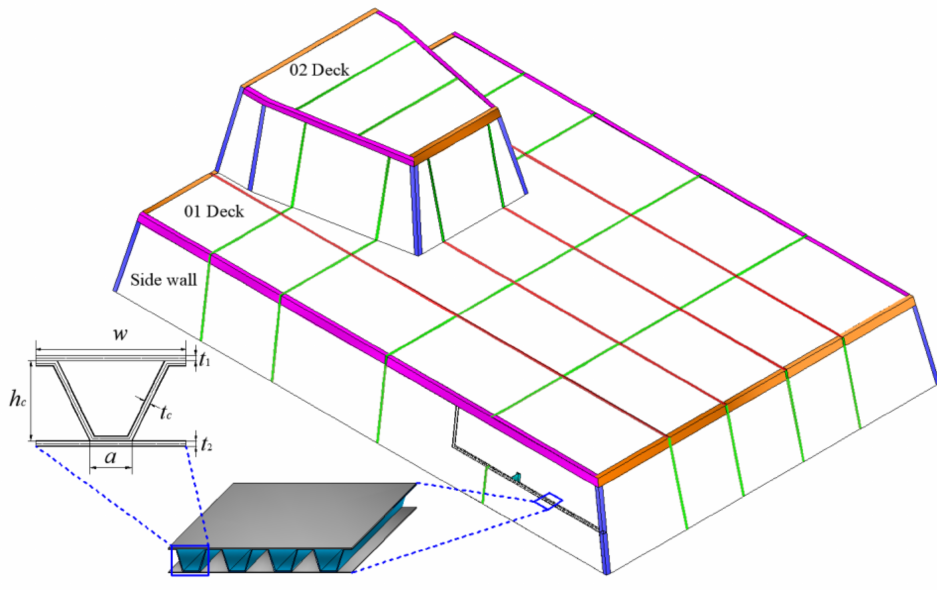
Figure 3. Basic structure of traditional superstructure and alternative